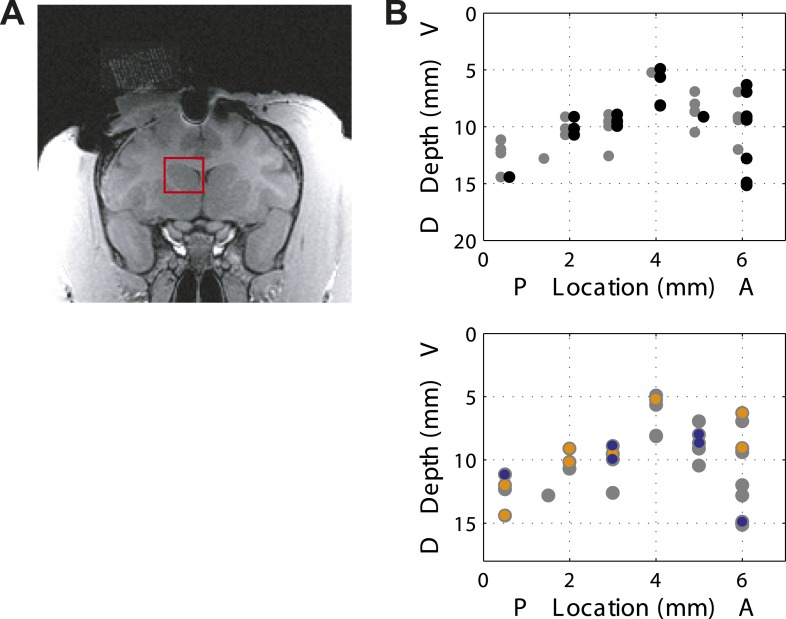
Location of recording sites.(A) Recording chamber showing access to the associative striatum (indicated in red square) in Monkey F. (B) (top) Distribution of recording sites for post-saccade (gray) and reward (black) neurons across two animals. AP = 0 corresponds to the anterior commissure. (bottom) Location of category-related neurons with selective response to slow (orange) and fast (blue) boundaries superimposed on the location of responsive neurons (gray).